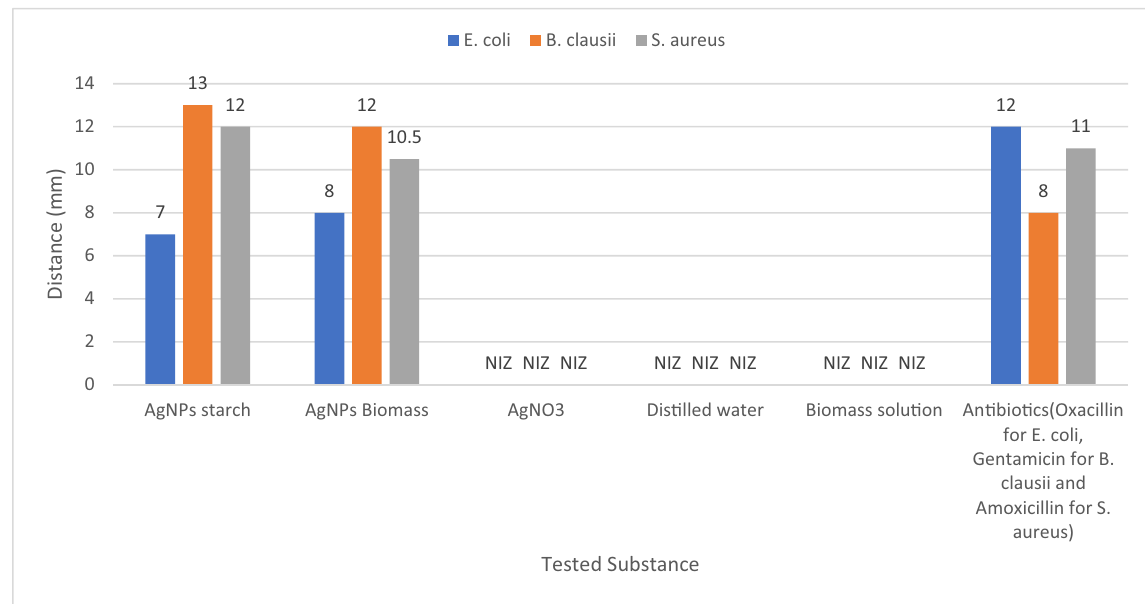
Figure 11: Comparative antibacterial e ff ect of synthesized AgNPs and other substances tested against B. clausii , E. coli , and S. aureus ( NIZ: no inhibition zone )